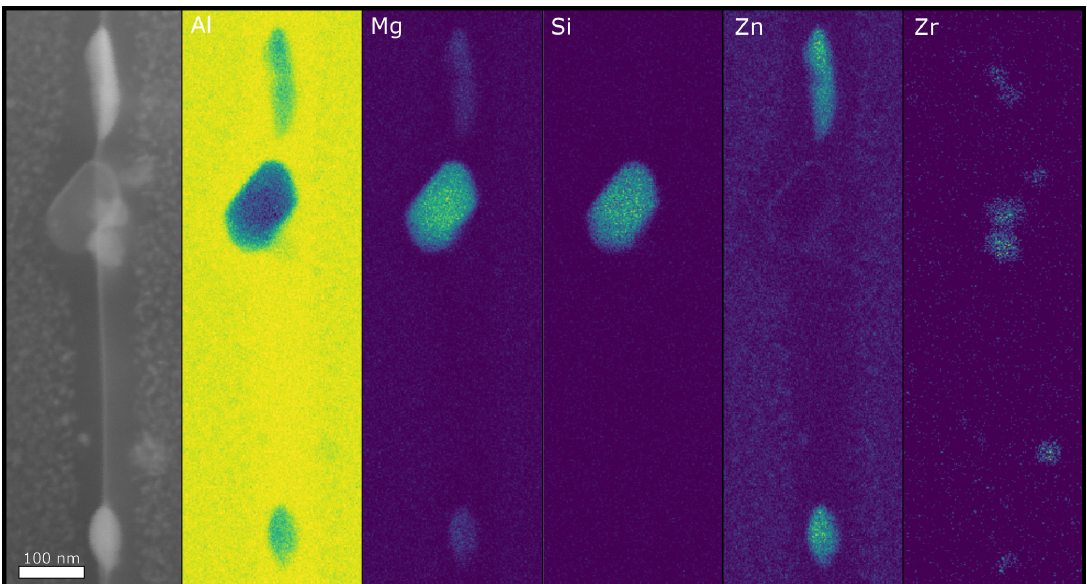
Figure 7. A HAADF-STEM image and corresponding EDS maps from a grain boundary in the sample H-AC-T6. Both MgZn 2 and β -Mg 2 Si particles are present if the material has been air-cooled from SHT. Al 3 Zr dispersoids are also found in connection with this grain boundary.